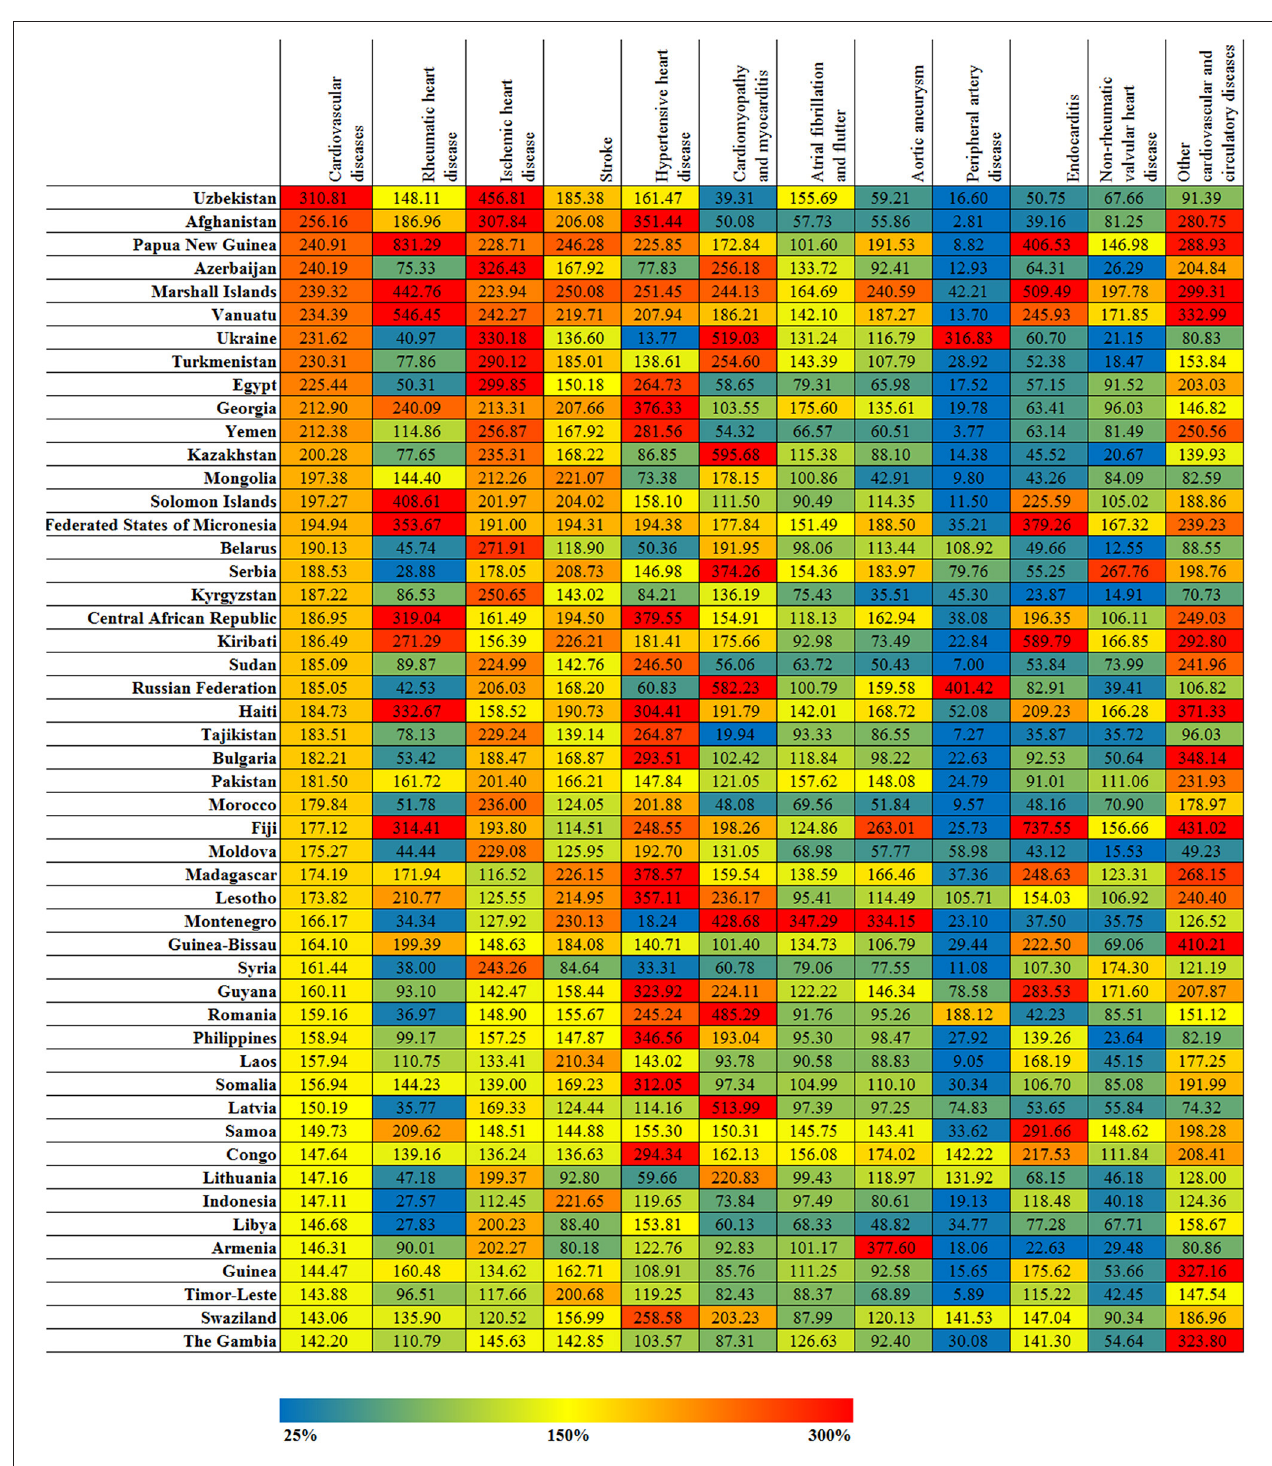
FIGURE 7 | The relative changed (%) in ASDR of cardiovascular disease and its 11 categories for top 50 countries and territories, between 1990 and 2017.